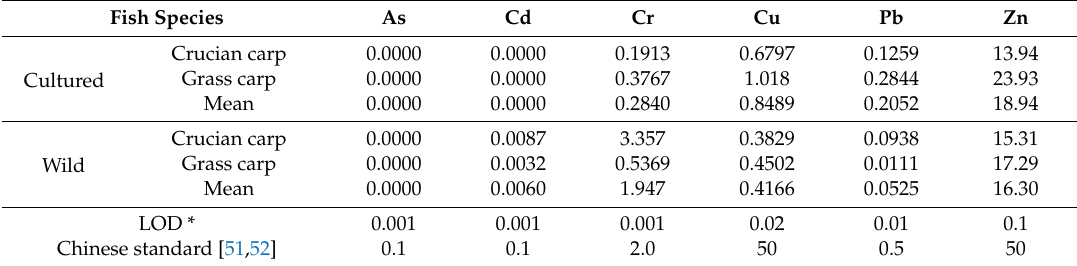
* LOD: Limit of Detection.